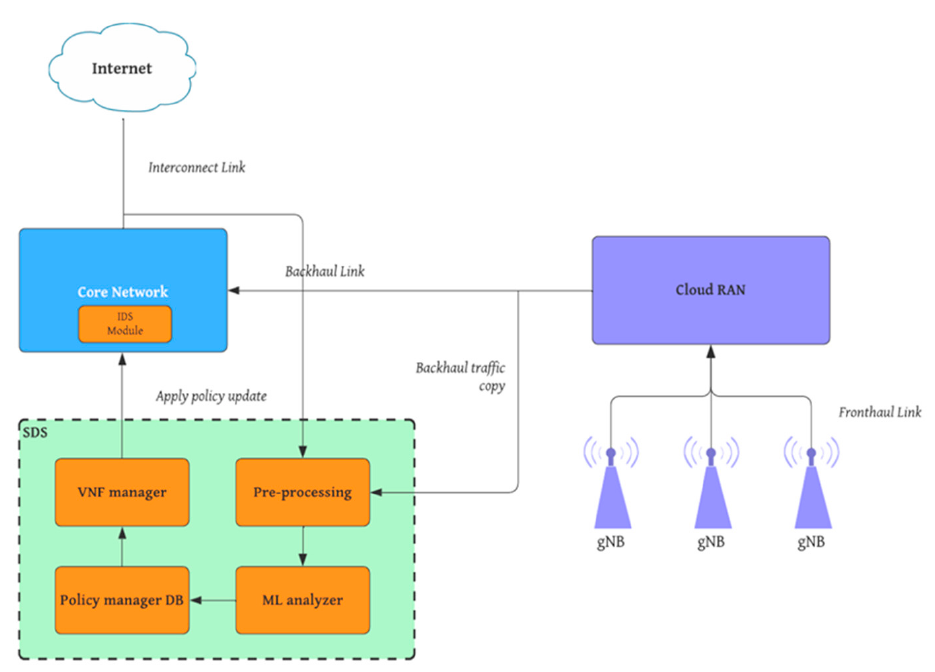
Figure 1. 5G network with IDS module system.